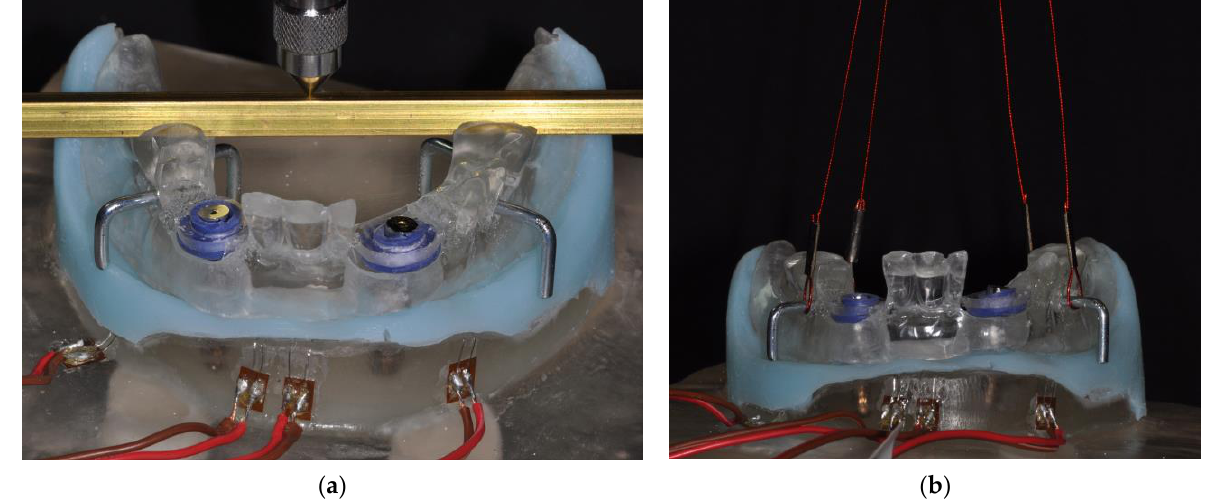
( b ) Figure 3. Existing patient situation with two interforaminal implants transferred to a resin model. ( a ) strain gauges were attached mesially and distally adjacent to the implants, capturing peri-im- plant strain development; ( b ) Model situation with gingival mask positioned and prototype abut- ments placed on the implants. Linear strain gauges (LY11- 0.6/120, 120Ω reference resistance, Hottinger Baldwin Messtechnik GmbH, Darmstadt, Germany) were attached to the model material mesially and distally adjacent to the implants [22] utilizing a measurement amplifier (Quantum X, Hottinger Baldwin Messtechnik GmbH, Darmstadt, Germany) and analyzing software (jBEAM, AMS GmbH, Chemnitz, Germany) for recording strains in the surroundings of the supporting implants at a sampling rate of 50/s. For determining the level of misfit strain generated by prosthesis insertion [22], the strain gauges were set to zero and the prostheses were manually positioned, ensuring the engagement of the attachments by applying finger pressure. Strain development in the